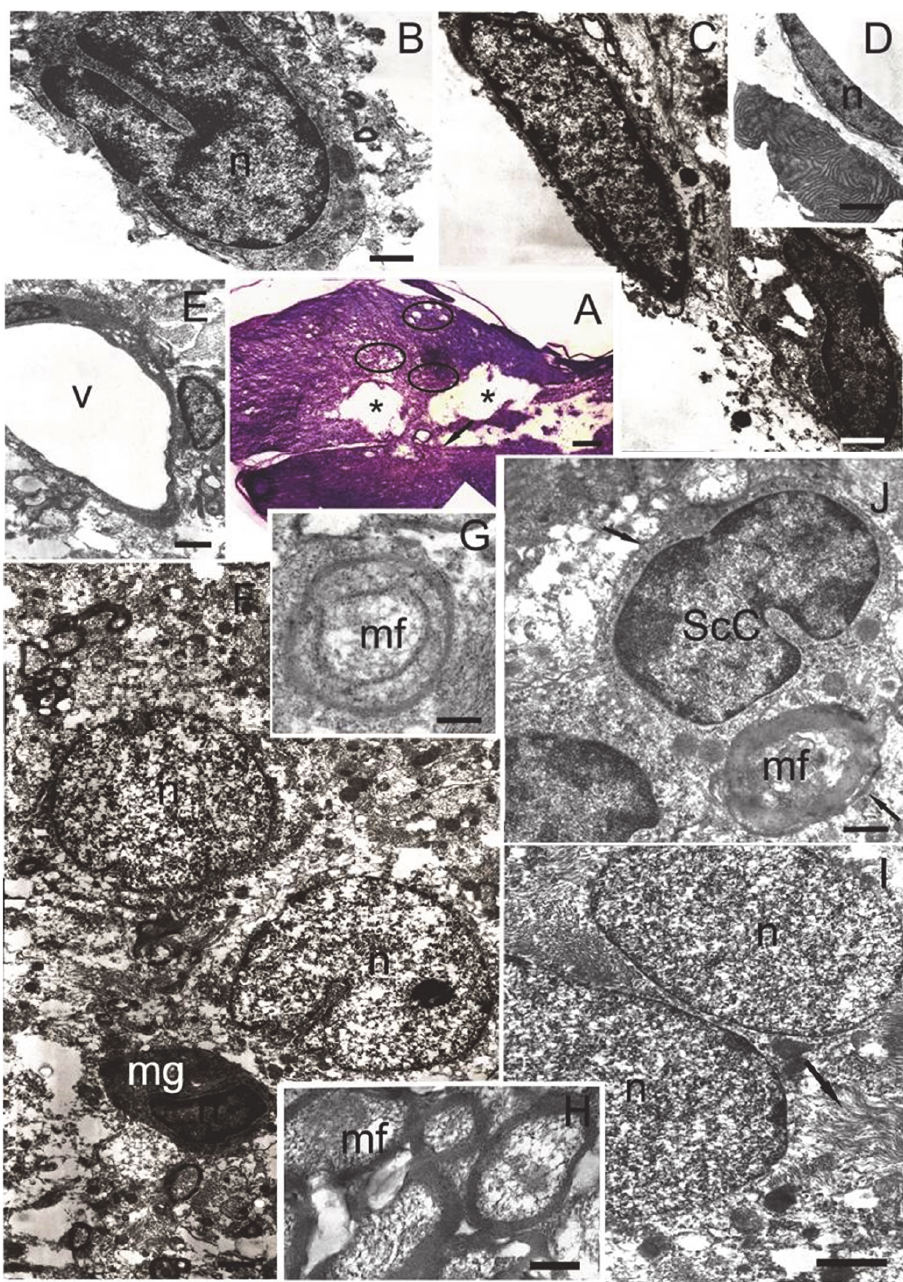
Figure 3: The morphological and ultrastructural features of the spinal cord tissue at day 30 after SCI and transplantation of hUCB-MCs. ( 0 ) Longitudinal section of the spinal cord (Weigert-Van Gieson’s stain). Asterisks show posttraumatic cavities, connected by narrow bands of cells. Arrow shows red-violet precipitate, indicating a specific reaction to the connective tissue. Marked oval areas indicate fields with small posttraumatic cavities. (B) Cell with irregularly or lobed-shaped nuclei containing heterochromatin in which lysosomes are visualized in the cytoplasm. Plasma membrane of this cell forms narrow invaginations that surround the remnants of degenerating nerve elements. (C) Two types of cells are located on the edge of posttraumatic cavity. Astrocytes have an elongated shape with electron-dense cytoplasm and elongated nucleus with euchromatin high electron density. Macrophages also have an elongated shape and electron-dense cytoplasm with lysosomes. The nucleus has an elongated irregular shape with heterochromatin. (D) Narrow spindle-shaped cell lines the edge of posttraumatic cavity and has an elongated shape nucleus with electron-dense cytoplasm. Organelles in the cytoplasm of cell are poorly identified. Near some of these cells we observed apoptotic bodies, consisting of electron-dense concentric lamellar structures along the periphery. (E) Blood capillary in the cavity border. (F) Two types of cells located in the cavity border. Astrocytes have electron-transparent cytoplasm with electron-dense small sized mitochondria and processes extending between the nerve elements and vessels. Microglia are small cells with electron-dense nucleus and cytoplasm in which cisternae of endoplasmic reticulum have a lighter intermembrane space. (G) Mesaxon myelination on the axial cylinder. (H) Clusters of small myelinated fibers with a very thin myelin sheath in the rostral directions from the epicenter of injury. (J) Myelin-forming Schwann cells. Arrows indicate the basal membrane. (I) Fibrous astrocytes have cytoplasm with a plurality of parallel extending bundles of intermediate filaments (arrow). Scale bar: 200 𝜇 W ( 0 ), 1 𝜇 W (B, C, G), 2 𝜇 W (H, I), 5 𝜇 W (D, F), 7 𝜇 W (E), and 500 nm (J). n: nucleus; v: vessel; mf: myelin fiber; ScC: Schwann cell; mg: microglial